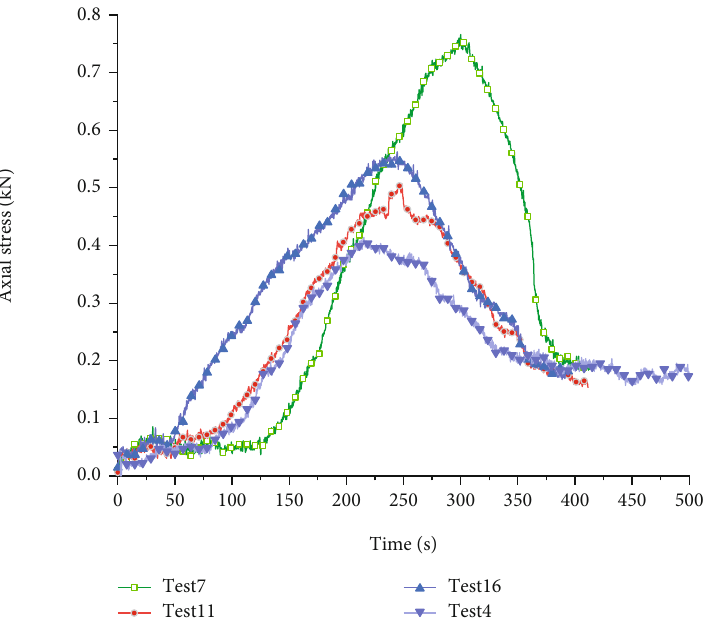
Figure 5: Uniaxial compressive stress-time curves of the crushed rock